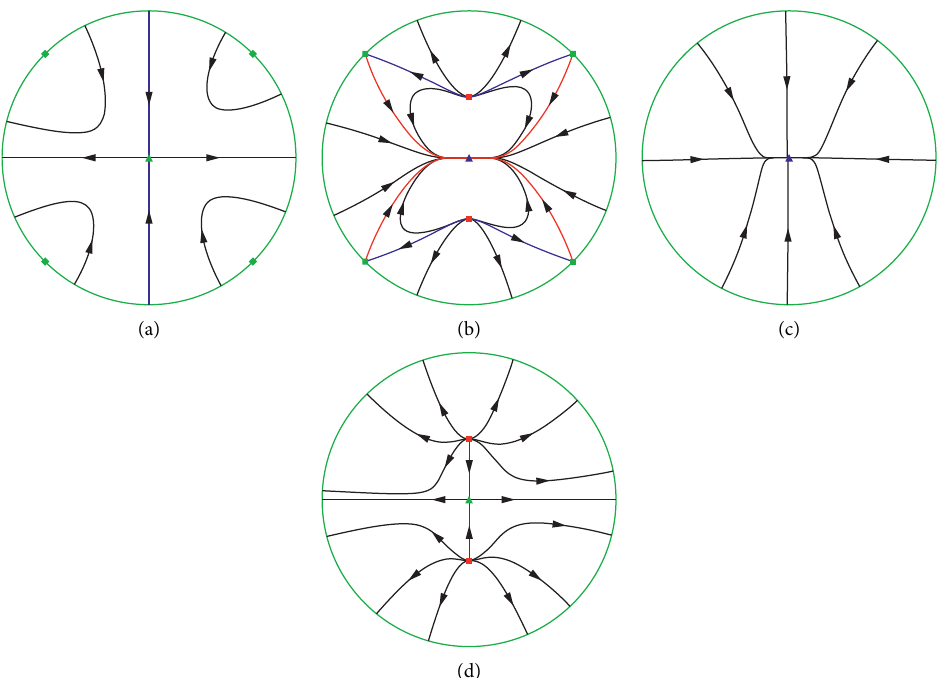
Figure 12: Trajectories in the global phase portraits of system (29). (a) Trajectories in the global phase portraits of system (29) for b > 0 and c > 0. (b) Trajectories in the global phase portraits of system (29) for b < 0 and c < 0. (c) Trajectories in the global phase portraits of system (28) for b < 0 and c > 0. (d) Trajectories in the global phase portraits of system (29) for b > 0 and c <